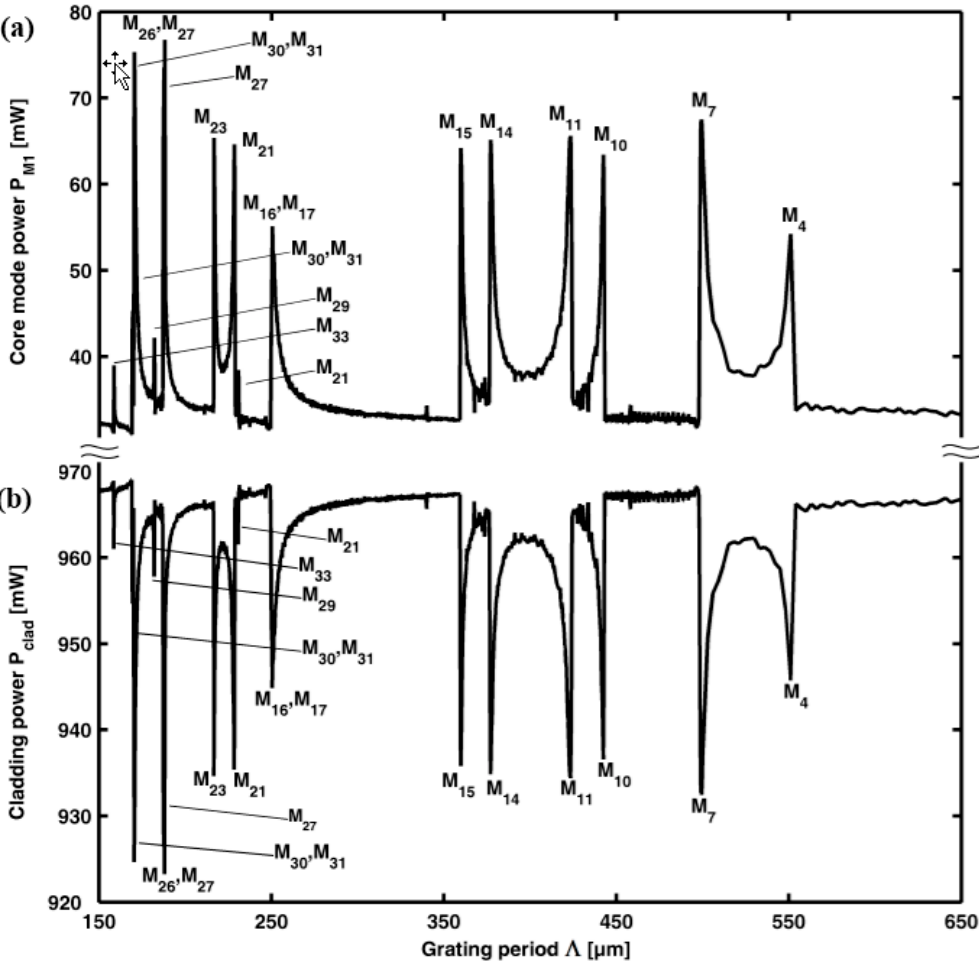
Figure 5. Resonances for a LPG inscribed into the MOF of the Section A-sensor versus the grating period Λ , at the pump wavelength λ P , LPG length L = 10 cm: ( a ) Core mode power P M1 ( λ P ); and ( b ) Cladding power P clad .